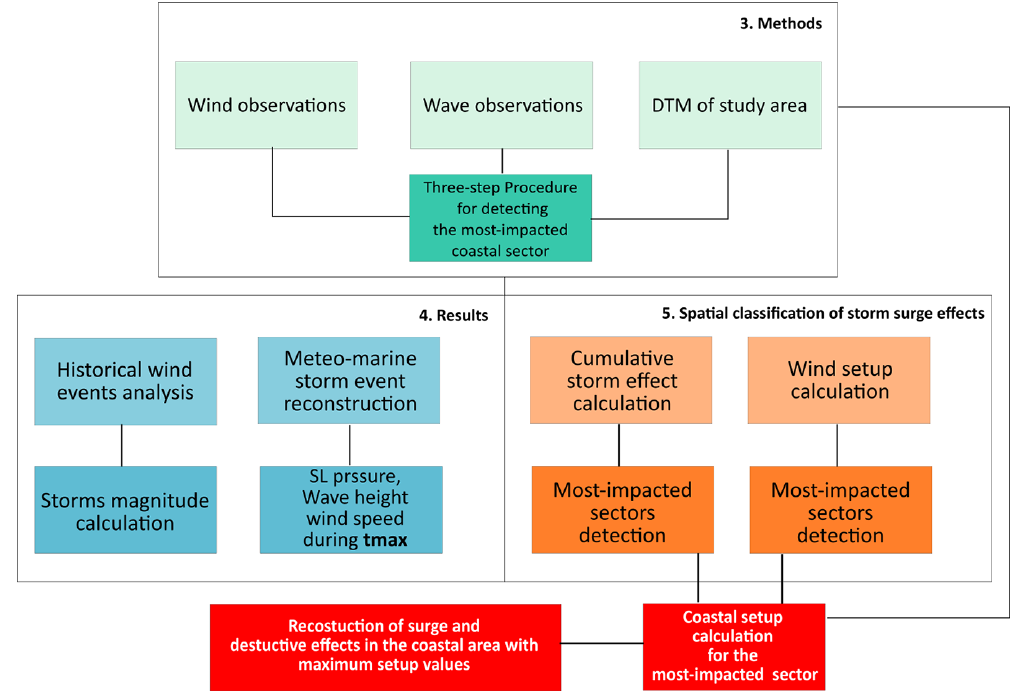
Figure 2. Workflow of the procedure applied in this study to evaluate the most impacted coastal sectors in the Gulf of Naples during